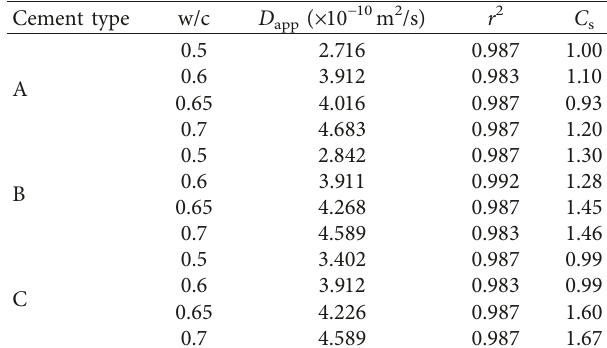
Figure 24: Error function fitting for (A) SW (w/c 0.7, Cl − ), D Table 4: D 2 values after exposure to SW for Cl − . Table 5: D app and r